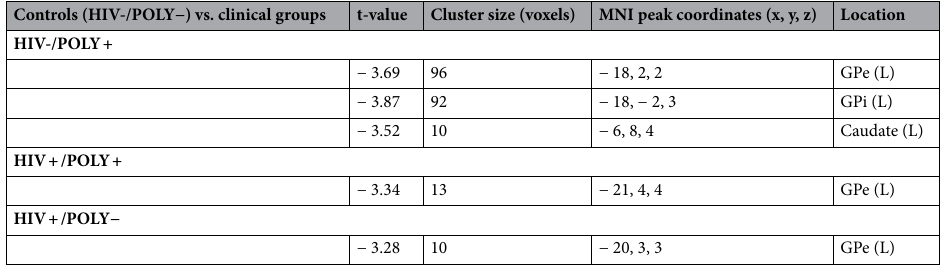
Table 5. Gray matter ROI volume differences between controls versus clinical groups within the basal ganglia. Data represent clusters with significant GM reduction in the basal ganglia in each clinical group relative to that of controls ( p < 0.05 FWE with a cut-off threshold of ≥ 5 voxels) in each ROI within the basal ganglia. L = left; R = right.